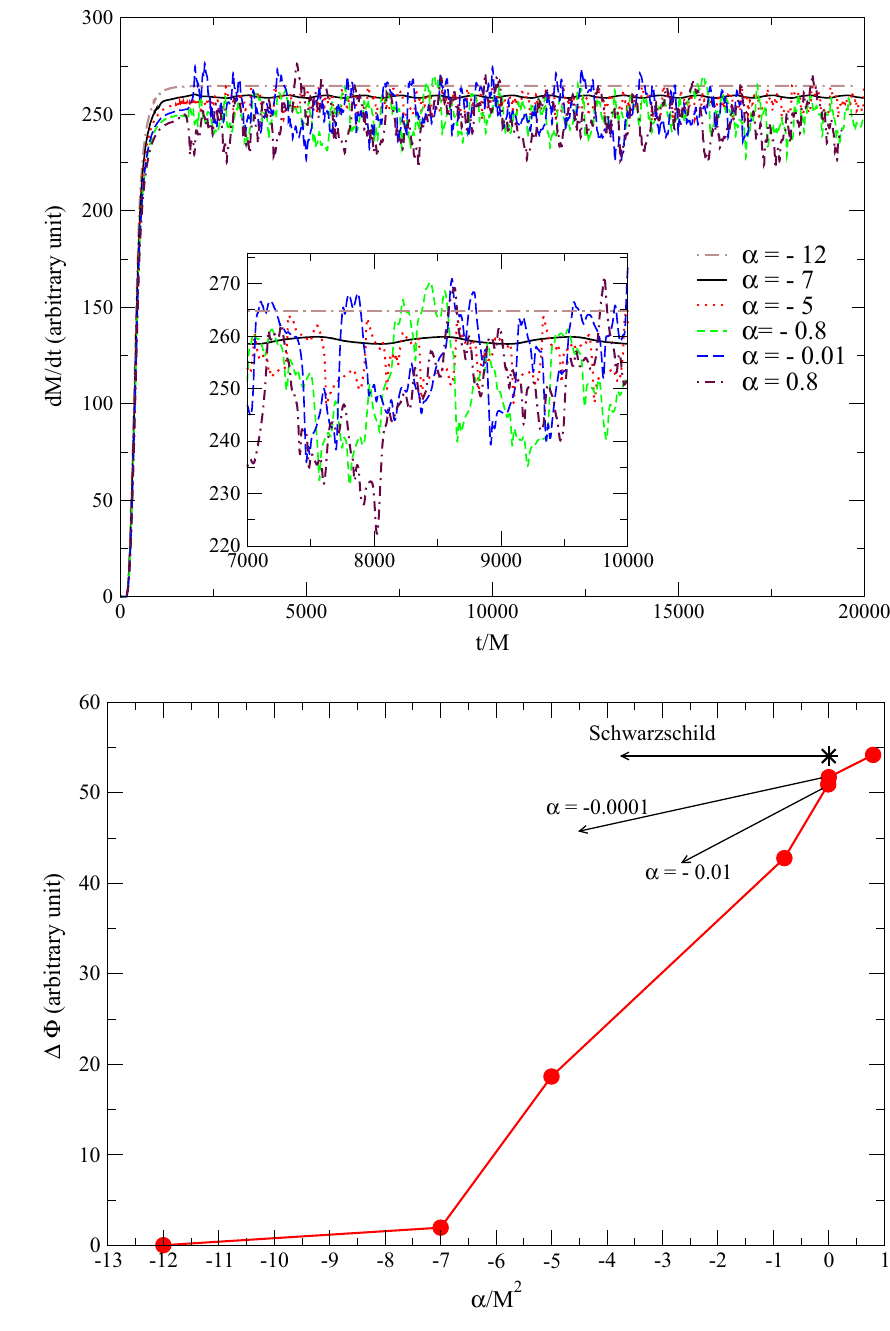
Fig. 4 Mass accretion rate as a function of time for varying values of α at r = 6 . 1 M . The accretion rates reach the steady state around t (cid:12) 1900 M in all